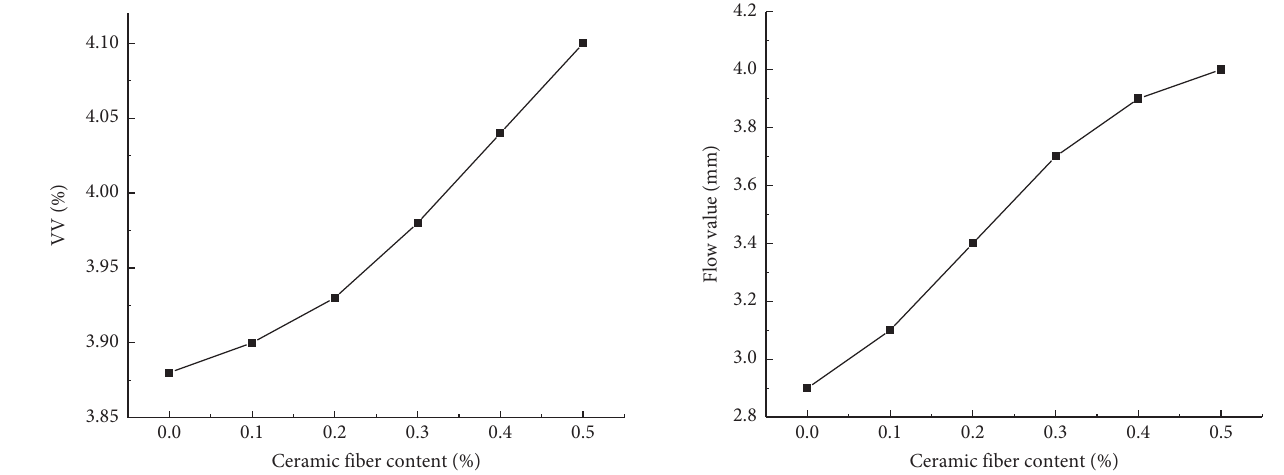
Figure 8: Relation between flow value and CF